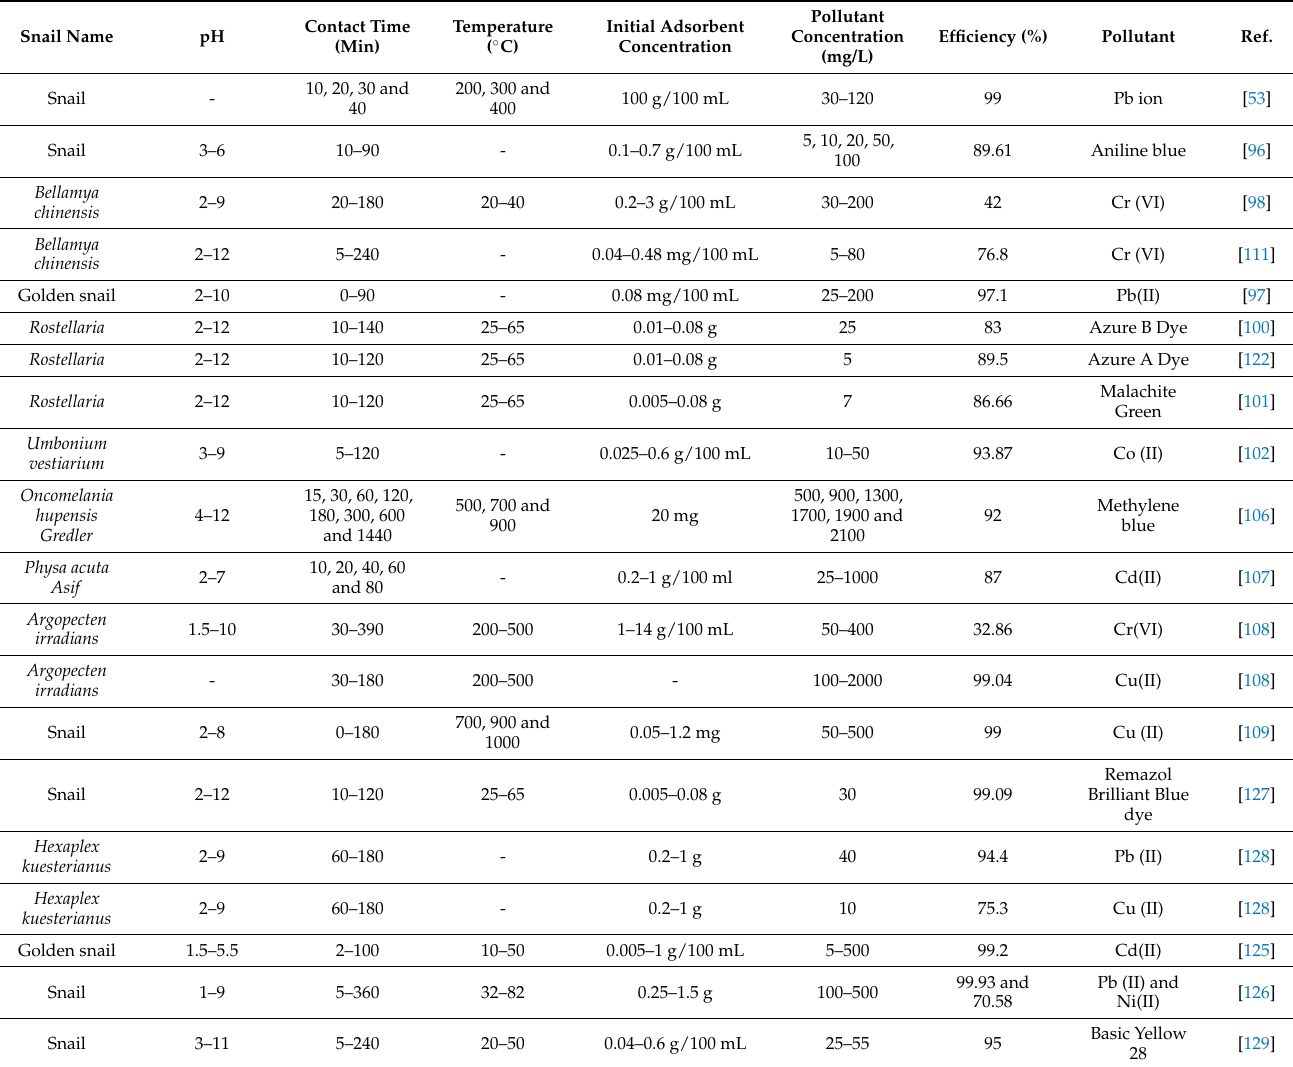
Table 5. Parameters and conditions affecting the heavy-metal adsorption process of snail